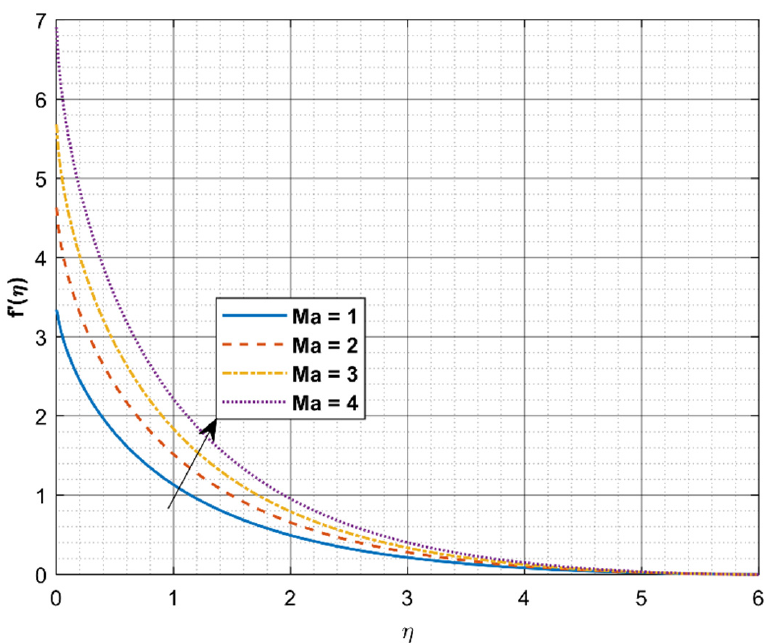
Figure 6. Influence of Ma on f (cid:48) ( η ) .